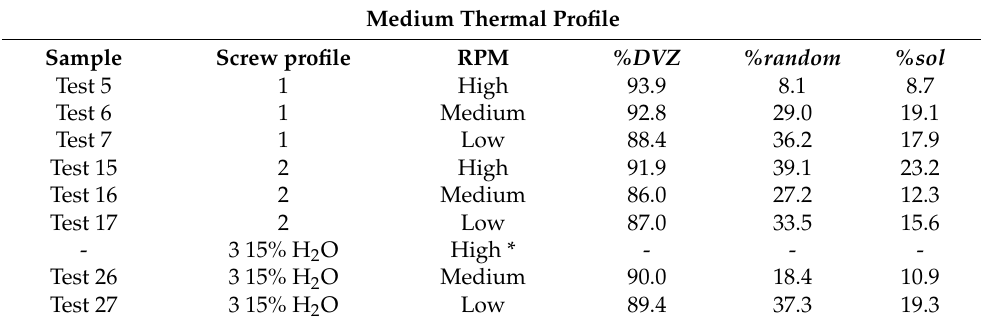
Table 4. %DVZ, %random, and %sol for devulcanization carried out at medium thermal profile.